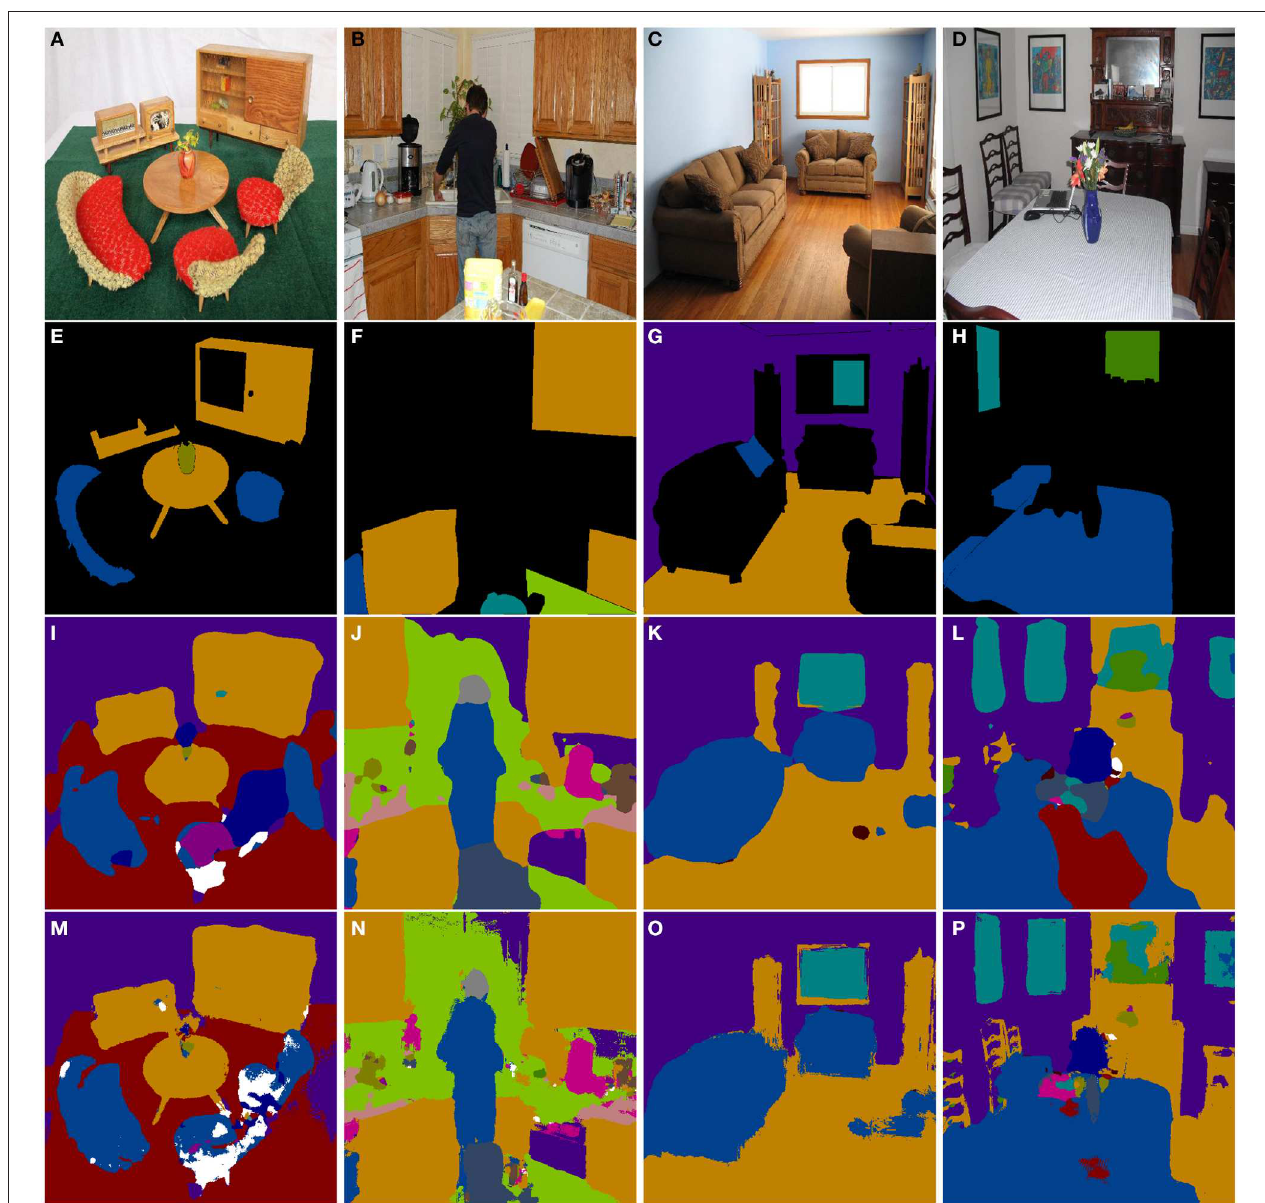
FIGURE 5 | Material segmentation in MINC dataset. From left to right, top to bottom, the IDs of the sub-figures are (A–P) . The first row, i.e., (A–D) , are original RGB images, the second row, i.e., (E–H) , are ground truth images, the third row, i.e., (I–L) , are semantic segmentation results of FCN, and the fourth row, i.e., (M–P) , are semantic segmentation results of FCN with